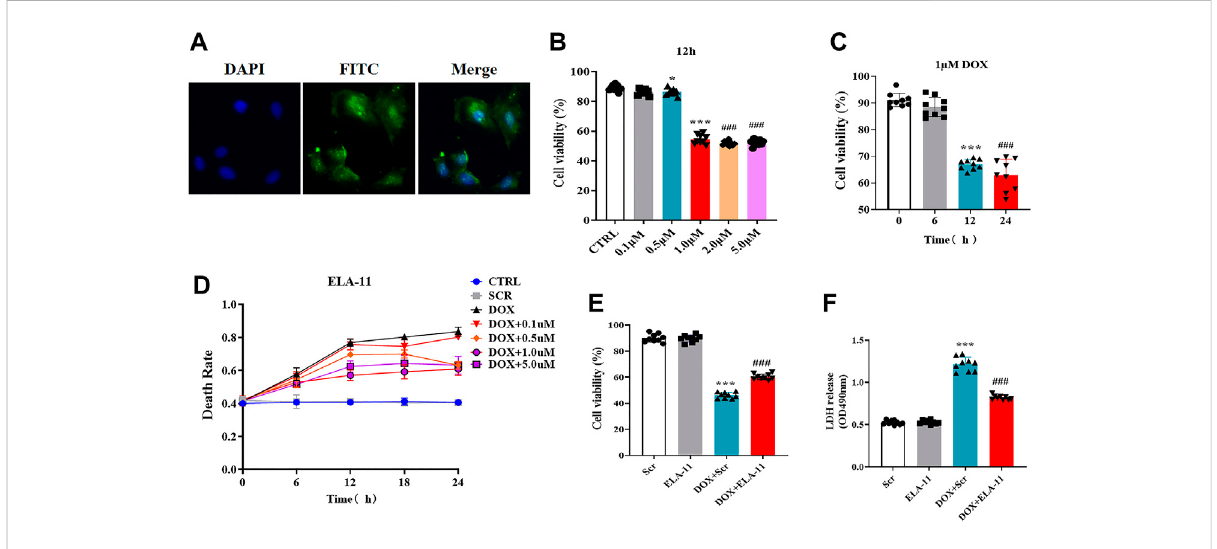
FIGURE 3 ELA-11 attenuates doxorubicin-induced injury in rat primary cardiomyocytes. (A) The location of ELA-11 in rat primary cardiomyocytes. (B) Trypan blue assay for cell death with different concentration of DOX with different duration (N = 9 per group). (C) The cell viability of 1 uM DOX in differentduration(N=9pergroup). (D) CellviabilityofELA-11withdifferentconcentrationfor12 h(N=9pergroup). (E) CellviabilityinDOX-induced cardiomyocyte model (N = 9 per group). (F) LDH release in DOX-induced cardiomyocyte model (N = 9 per group). *** p < 0.001 and ### p < 10.001, one-way